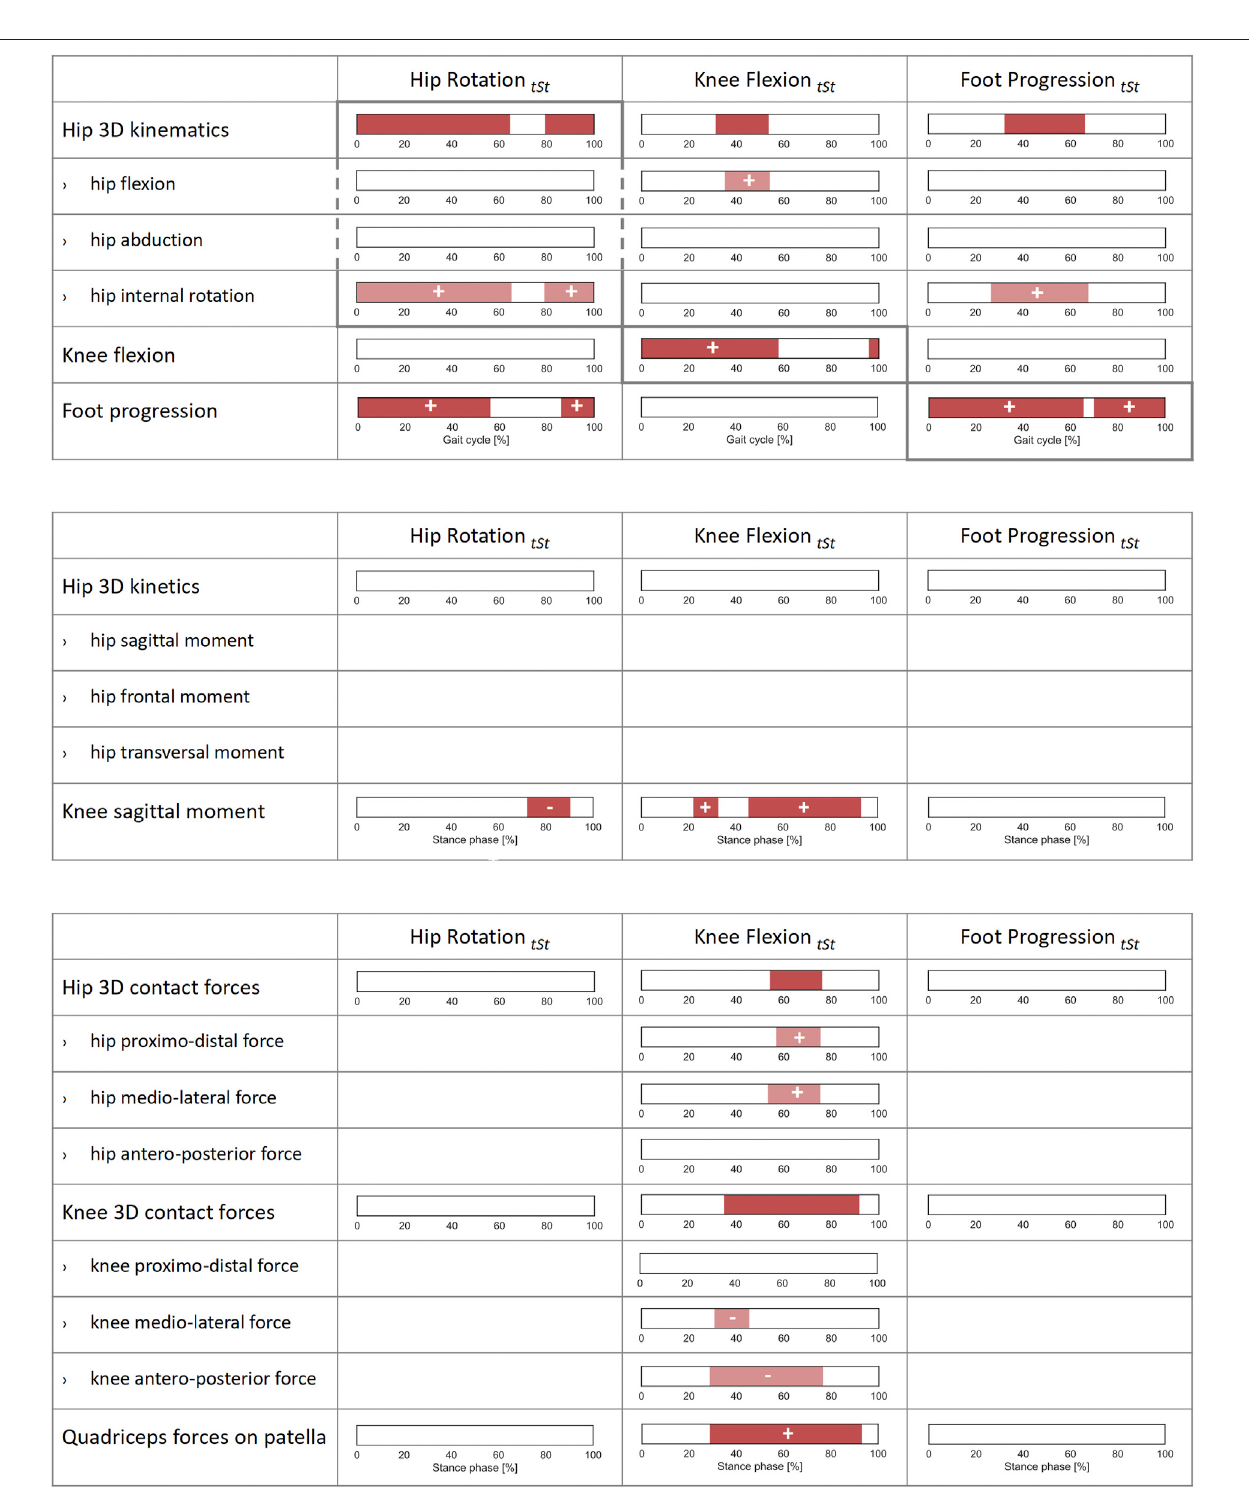
FIGURE 5 | Correlations of joint kinematics, joint moments, and forces with synthetic gait-pattern-related kinematic descriptors (HipRot tSt , KneeFlex tSt , FootProg tSt ,de fi ned,respectivelyasthemeanvalueofhiprotation,knee fl exion,andfootprogressionduringterminalstance)acrossthepatients ’ cohort.SPMcanonical correlation analyses (CCAs) or scalar linear regressions were used to identify potential correlations of the 3D vector fi elds and 1D scalar outcome variables with the independentpredictors.Intervalsofthegaitcycleforjointkinematics,andintervalsofthestancephaseforjointmomentsandforces,characterizedbyastatistically signi fi cant correlation in the relevant SPM test are reported as red bars. Post-hoc scalar linear regressions were conducted on the individual components of the vector fi elds,for which intervalswithsigni fi cantcorrelationsare reported inlightred. Thesign ofthecorrelationisindicated on each interval forall scalar linear regressions. Fora correct interpretation of the directionality of the correlation, the reader is referred to the axes reported in the corresponding graphs in Figures 1 , 2 .